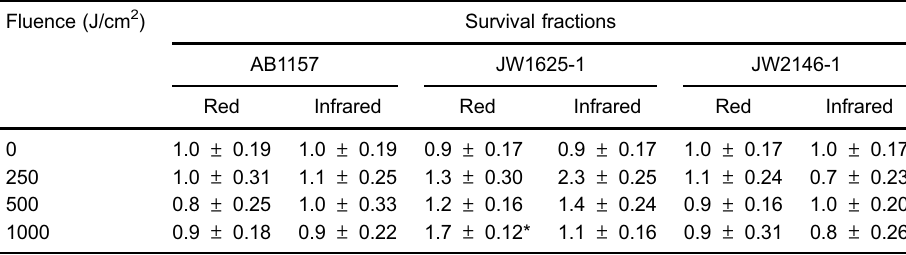
Table 3. Survival fractions of E. coli cultures exposed to low-intensity red and infrared lasers in stationary growth